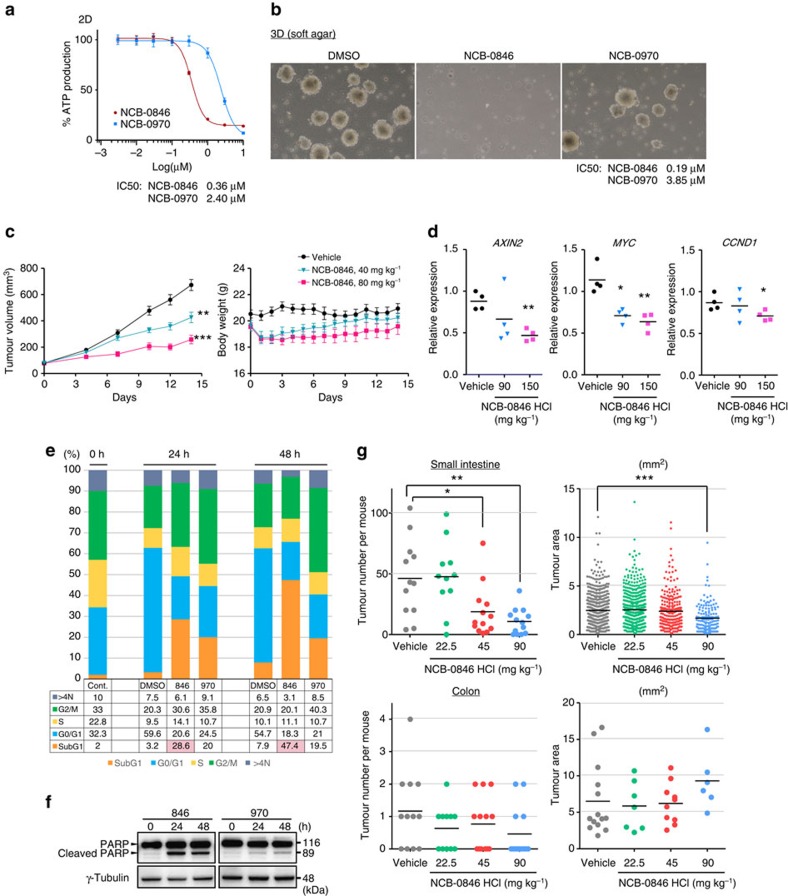
NCB-0846 inhibits cancer cell growth in vitro and in vivo.(a) ATP production of HCT116 cells cultured with escalating doses of NCB-0846 or NCB-0970 for 72 h. IC50 values were obtained by fitting a four-parameter dose–response curve to normalized data using GraphPad Prism software. Data represent the mean of six replicates. (b) Inhibition of colony formation by HCT116 cells in soft agar. Cells were embedded in top agar, covered by media containing DMSO, NCB-0846 (1 μM) or NCB-0970 (1 μM), and cultured for 14 days. (c) HCT116 cells were inoculated into the subcutaneous tissues of 9-week-old female BALB/c-nu/nu mice. When the volume of the xenografts reached ∼80 mm3, the mice were administered daily with 0 (vehicle alone, n=9), 40 (n=9) or 80 mg kg−1 (n=9) BID (bis in die) NCB-0846. **P<0.01, ***P<0.001 (Dunnett's multiple comparison test). Error bars represent s.e.m. (d) Pharmacodynamics analysis. Mice carrying HCT116 xenografts of ∼650 mm3 received a single oral dose of 0 (distilled water, vehicle control, n=4), 90 (n=4) or 150 mg kg−1 (n=4) NCB-0846 HCl (hydrochloride salt of NCB-0846). The tumours were excised, and the expression of AXIN2, MYC and CCND1 was quantified by RT–PCR and normalized to ACTB. *P<0.05, **P<0.01 (Student's t test). (e) HCT116 cells were untreated (0 h) or treated with DMSO (control), NCB-0846 (3 μM) or NCB-0970 (3 μM) for 24 or 48 h. The percentage of cells in each cell cycle fraction was determined by flow cytometry. (f) HCT116 cells were treated with DMSO (control), NCB-0846 (1 μM) or NCB-0970 (1 μM) for 24 or 48 h. The expression of PARP-1 and γ-tubulin (loading control) was determined by immunoblotting. (g) Effects of NCB-0846 HCl on tumorigenicity in the small intestine and colon of Apcmin/+ mice. NCB-0846 HCl or water (VEH, vehicle) was orally administered BID for 35 days (10–15 weeks after birth). Data represent mean±s.e.m of 11–13 mice (Vehicle, n=12; 22.5 mg kg−1, n=11; 45 mg kg−1, n=13; 90 mg kg−1, n=13). ***P<0.001, **P<0.01 and *P<0.05 (Dunnett's test) relative to the vehicle-treated group.